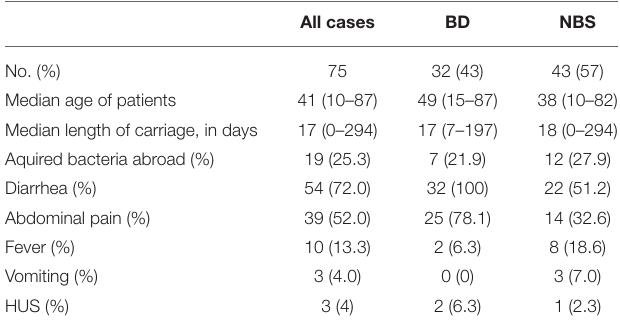
TABLE 3 | Patient data and clinical symptoms for all STEC infections yielding